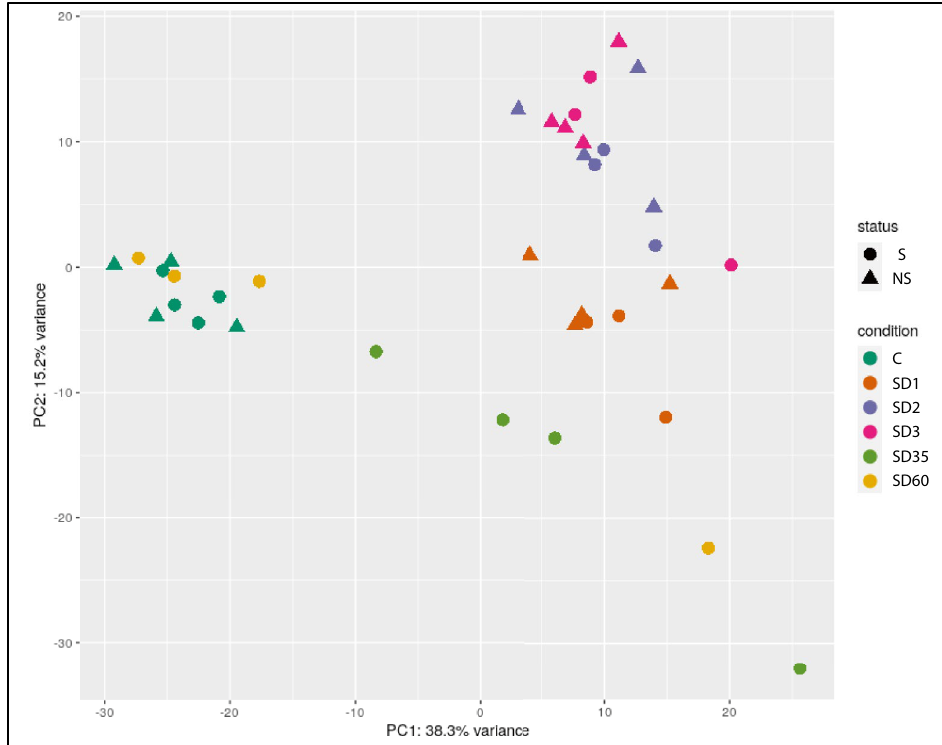
Figure 3. 2D-PCA plot of overall gene counts showing a tight clustering within group and a clear separation among different comparative groups. Survivors are marked as S, while non-survivors are marked as NS. Figure is created by open source software R (version 4.0.3, https:// cran.r- proje ct.